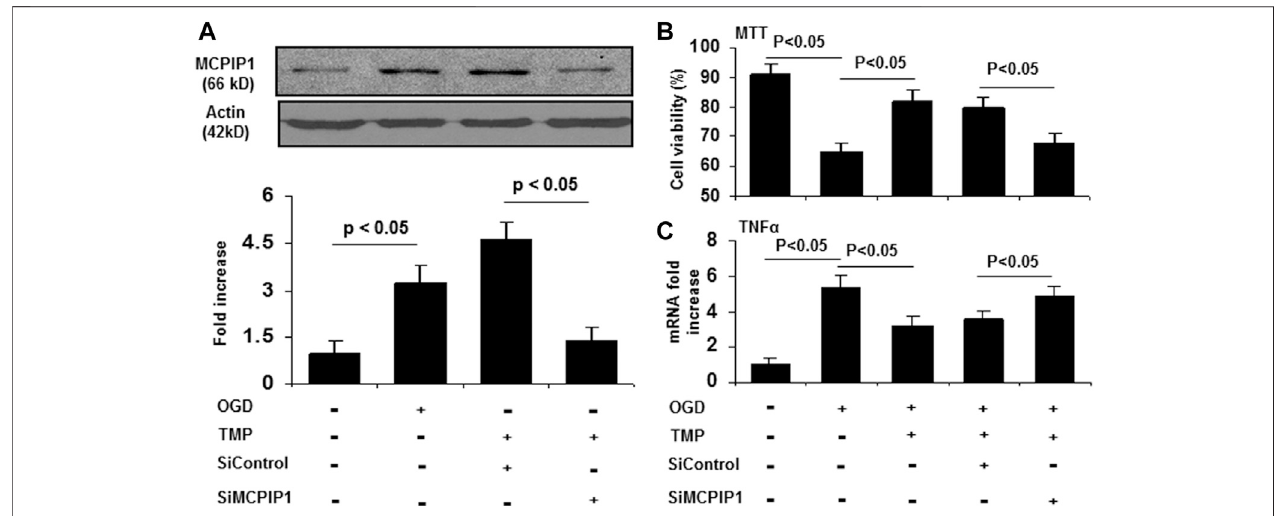
FIGURE 5 | The neuroprotective effects of TMP is blocked by knockdown of MCPIP1 in vitro. The primary cultured mouse cortical neurons were pretreated with siRNAagainstMCPIP1for24 h,followedbytreatmentwithTMP(10 μ M)for12 h.Thecellswerethensubjectedtooxygen-glucosedeprivationfor24 h.Cellviabilitywas assessed by MTT assays. mRNA levels for MCPIP1 and TNF- α were determined by qRT-PCR. Experiments were repeated three times. (A) Expression of MCPIP1 was detected by immunoblots ( Upper panel ) , and immunoreactive bands were quanti fi ed by densitometry analysis normalized to β -actin, and expressed as fold changesovertheuntreatedcontrols ( Lowerpanel ) (n (cid:1) 3). (B) CellviabilitywasevaluatedbyMTTassays(n (cid:1) 3). (C) TNF- α mRNAlevelswereassayedbyqRT-PCR(n (cid:1) 3).